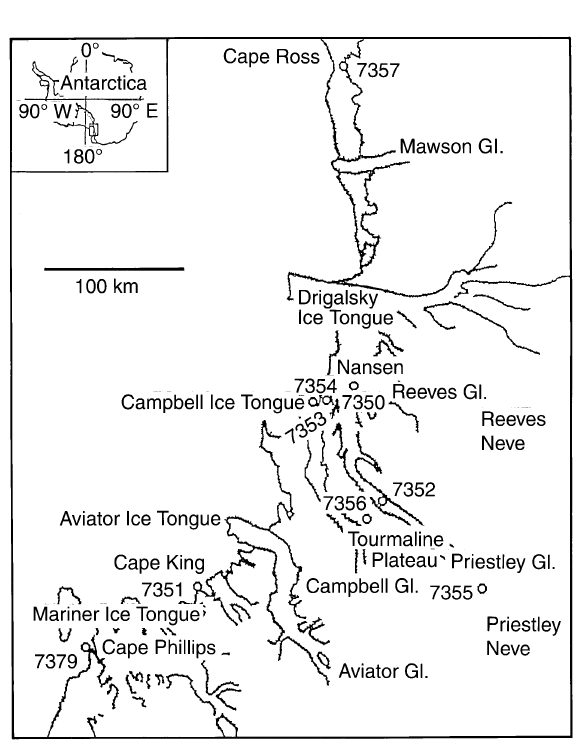
Fig. 1. Sketch map of Victoria Land and AWS locations